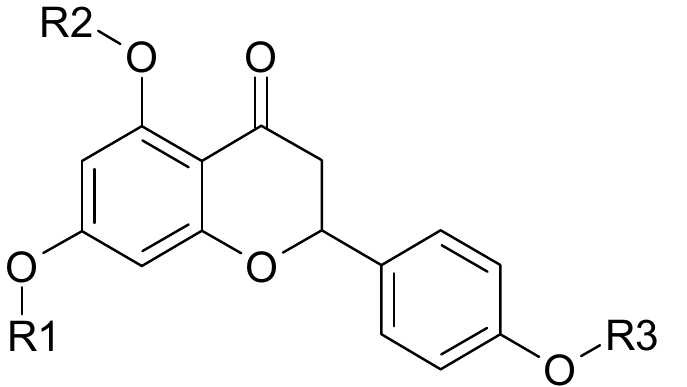
Figure 1. Naringeninanditsderivatives. Naringenin: R1 = H,R2 = H,R3 = H (1) ; 5,7,4 (cid:48) -tri- O -methylnaringenin: R1 = CH 3 , R2 = CH 3 , R3 = CH 3 (2) ; 5,7,4 (cid:48) -tri- O -ethylnaringenin: R1 = CH 3 CH 2 , R2 = CH 3 CH 2 , R3 = CH 3 CH 2 (3) ; 7- O -ethylnaringenin: R1 = CH 3 CH 2 , R2 = H, R3 = H (4) ; 7- O -pentylnaringenin: R1 = CH 3 (CH 2 ) 4 , R2 = H, R3 = H (5) ; 7,4 (cid:48) -di- O -ethylnaringenin: R1 = CH 3 CH 2 , R2 = H, R3 = CH 3 CH 2 (6) ; 7,4 (cid:48) -di- O - methylnaringenin: R1 = CH 3 , R2 = H, R3 = CH 3 (7) ; 7- O -methylnaringenin: R1 = CH 3 , R2 = H, R3 = H (8) .